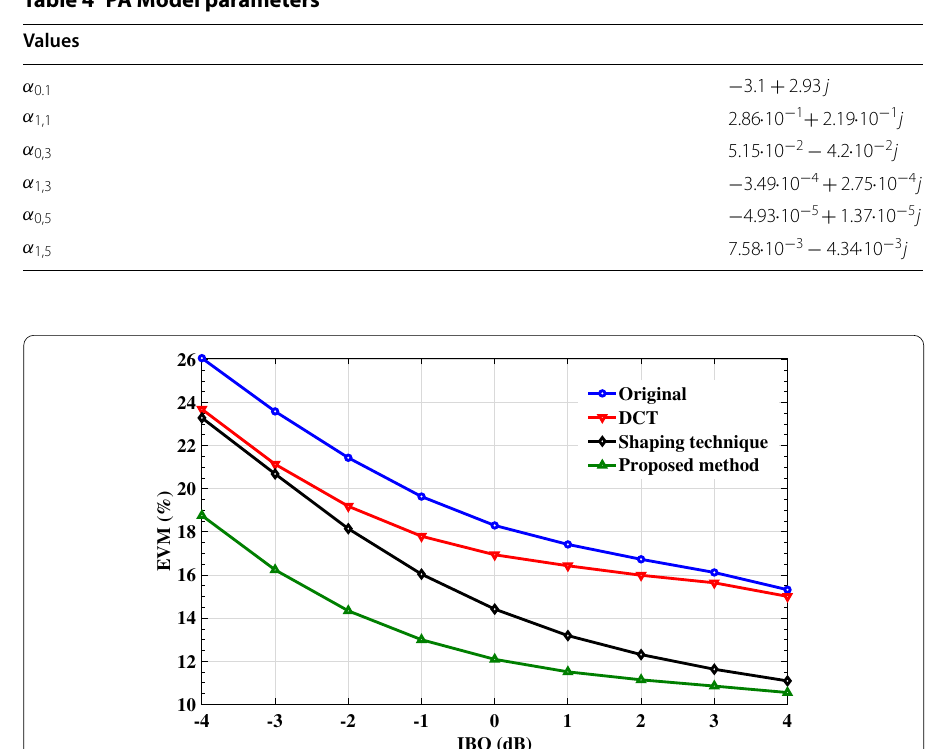
Fig. 12 Comparison of EVM versus IBO (SNR